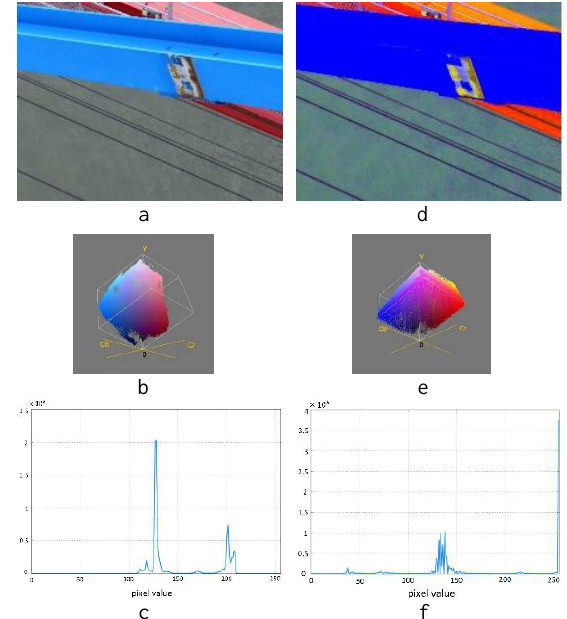
Figure 3. HSV transformation. First row relates to images before HSV transformation and second row shows their counterparts after HSV transformation. a, d) RGB image, b, e) 3D YCrCb histogram; c, f) histogram of the Cb channel of a, and